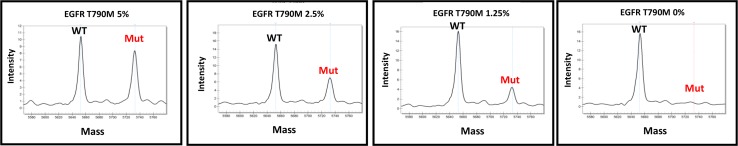
EGFR T790M dilution series.Example of a dilution series for detection of EGFR-T790M mutation (Horizon Discovery-Boston, Cambridge MA), showing spectral peaks of mutation and WT from 5% mutation VAF down to 0%.